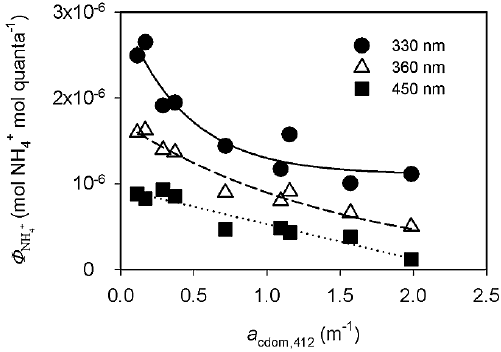
Fig. 8. Plot of NH + apparent quantum yield at 330nm vs. the molar 4 DON:DOC ratio. Data labels represent station Fig. 7. Regression analysis between NH + apparent quantum yields 4 and CDOM absorption coefficients at 412nm at three selected wavelengths, 330nm, 360nm, and 450nm. Data were fitted to the equations of Y = 1 . 1 × 10 − 6 + 1 . 9 × 10 − 6 exp ( − 2 . 3 X) at 330nm (solid line; r 2 = 0 . 914), Y = 1 . 7 × 10 − 6 exp ( − 0 . 65 X) at 360nm (dashed line; r 2 = 0 . 960), and Y = 9 . 3 × 10 − 7 − 4 . 1 X (dotted line; r 2 = 0 . 912).